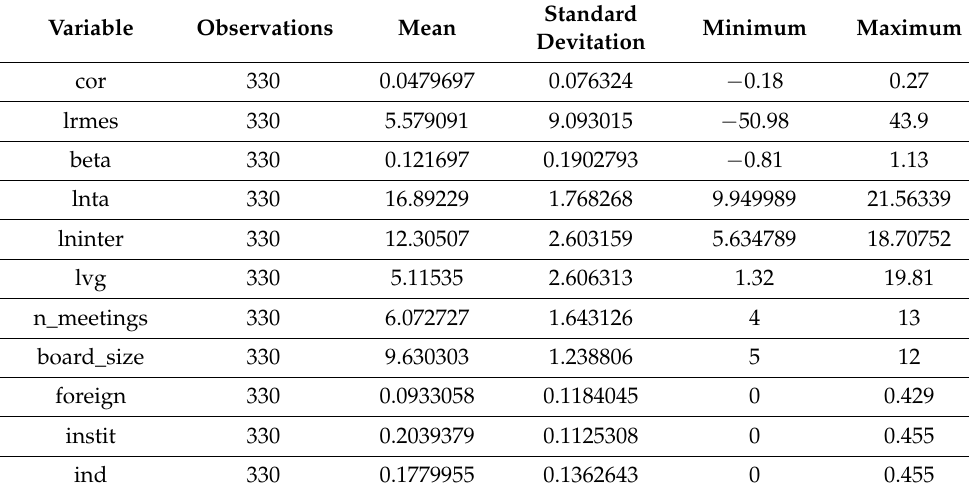
Table 3. Summary statistics and univariate